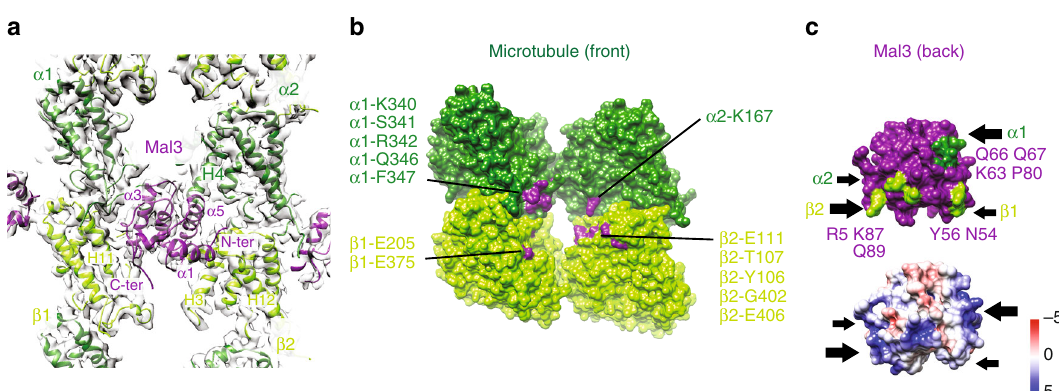
Fig. 6 Consequences of S. pombe MT architecture for Mal3 binding. a View from the outside of the Sp_tub MT of the Mal3 binding site at the corner of four tubulin dimers, with contacts made to α -tub1 and α -tub2 (dark green), β -tub1 and β -tub2 (light green). b Mal3 footprint on the MT surface with polar and charged tubulin residues < 4 Å distant from Mal3 colored purple and labeled. c MT-binding surface of Mal3; top, polar and charged Mal3 residues < 4 Å distant from the MT colored in green and labeled; bottom, charge distribution of the Mal3 MT-binding surface. The black arrows indicate the four contact points of Mal3 with the